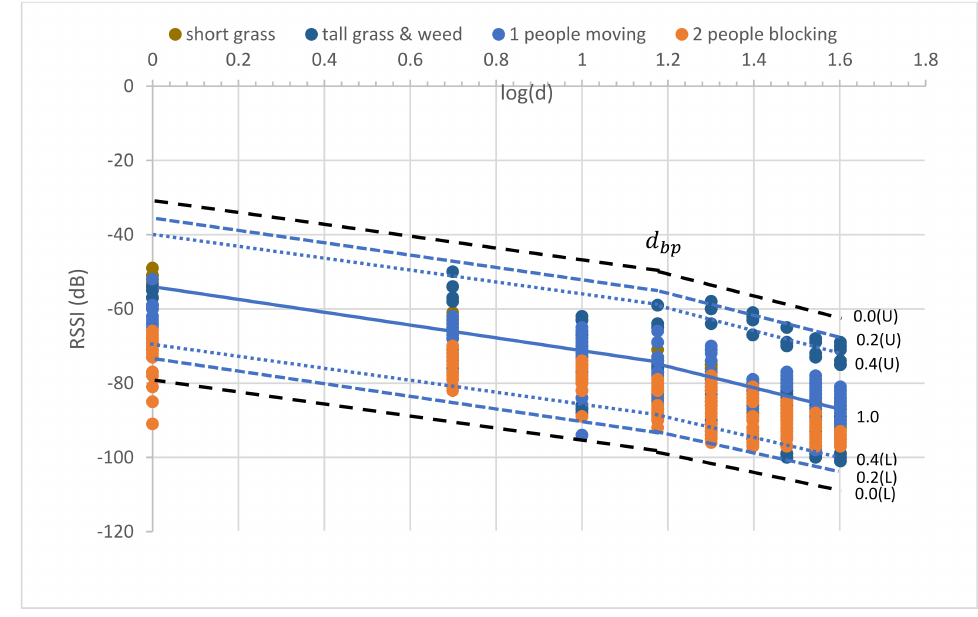
Figure 13. MBFLR for all fuzzy